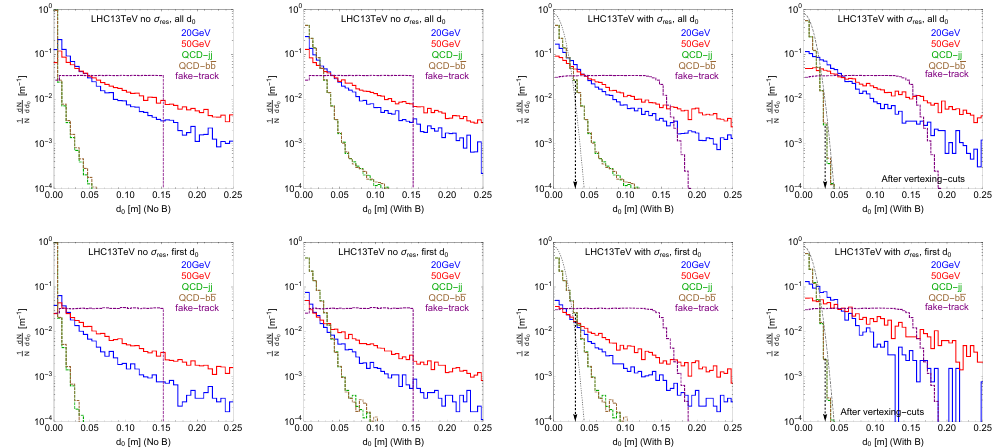
Figure 12 . (VBF channel) The distributions for transverse impact parameter d 0 for QCD back- ground, fake-track background and the signal. The parameter setup is the same as the ggF channel in figure 6 and figure